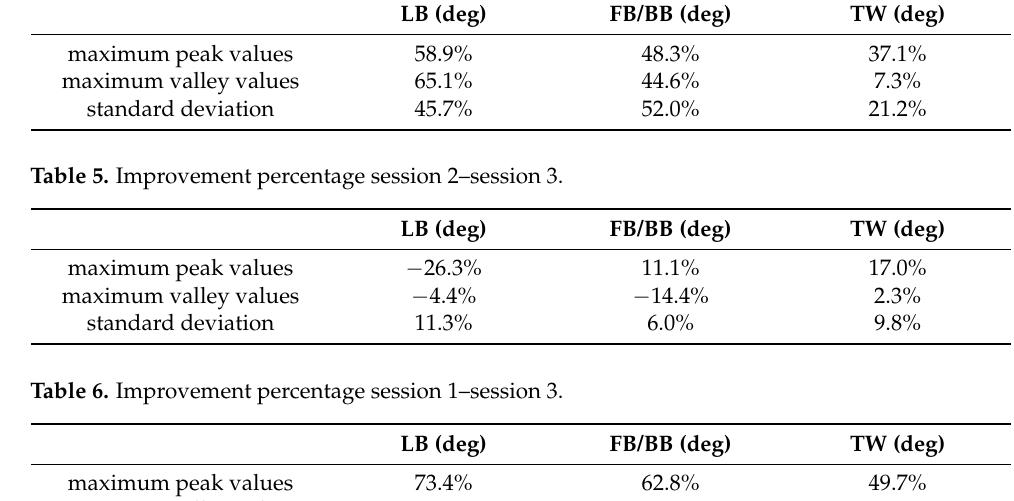
Table 6. Improvement percentage session 1–session 3.